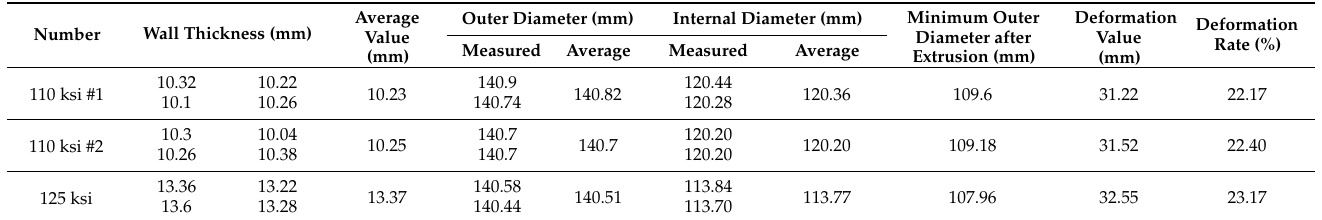
Table 1. Measurement results of casing wall thickness and outer diameter before and after extrusion tests.